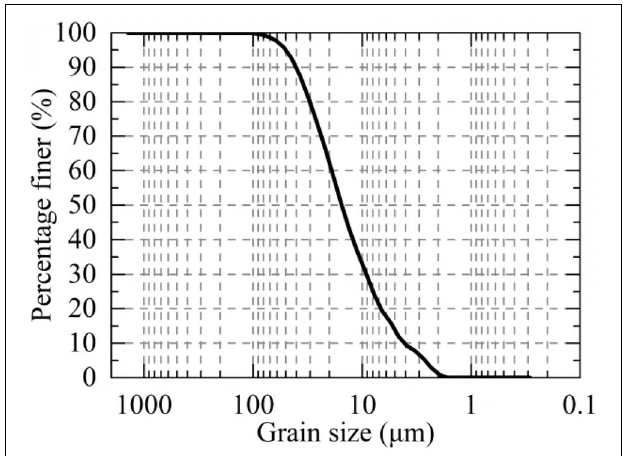
FIGURE 1 | Grain sizes distribution of clay samples.